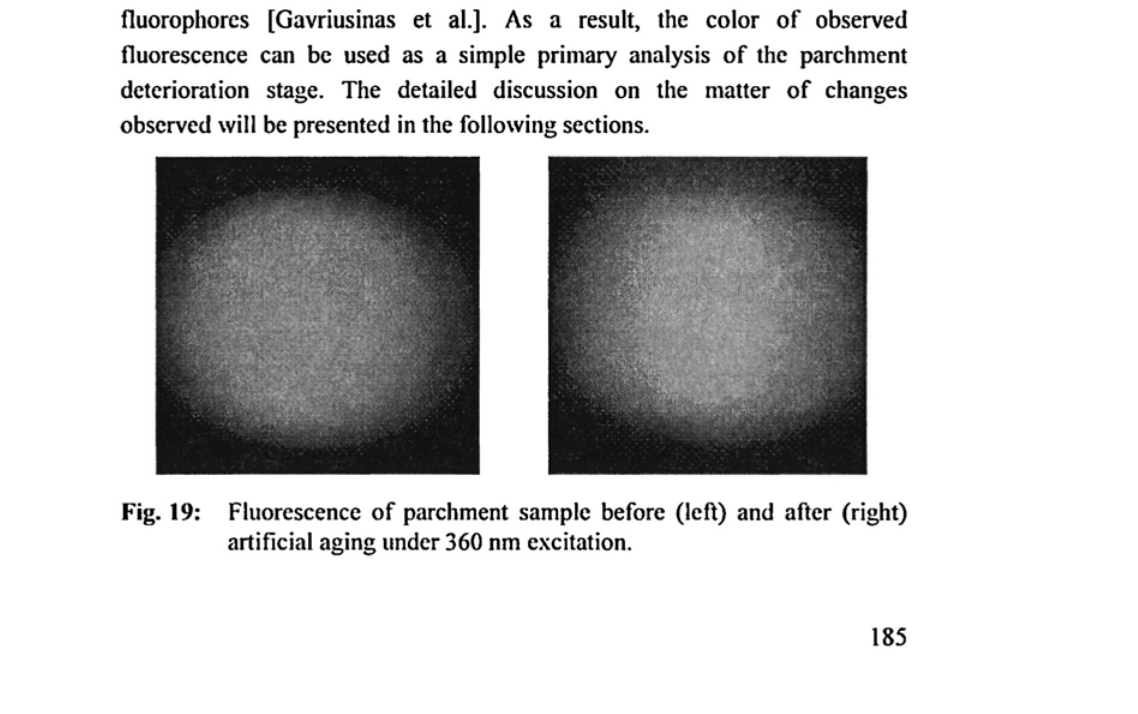
Fig. 19: Fluorescence of parchment sample before (left) and after (right) artificial aging under 360 nm